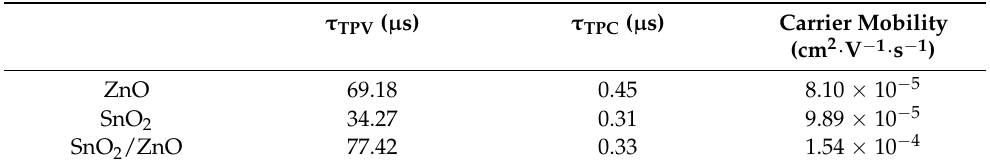
Table 3. The parameters derived from TPV/TPC and Photo-CELIV measurements for the devices with different cathode buffer